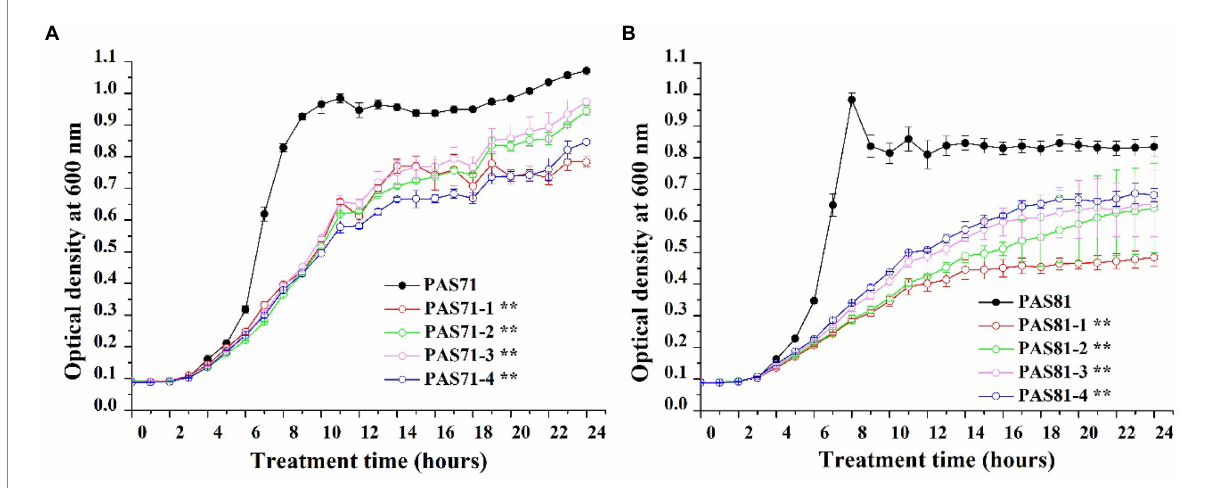
FIGURE 2 Growth curves of Pseudomonas aeruginosa PAS71 and PAS81 parental strains and their four heteroresistant subpopulation isolates. (A) The P. aeruginosa PAS71 parental strain and its four heteroresistant subpopulation isolates. (B) The P. aeruginosa PAS81 parental strain and its four heteroresistant subpopulation isolates. k value denotes slope of growth curve cultured for 6 to 10 h; ** indicates an extremely significant difference in k value with p < 0.05 compared with the parental train based on the independent Student’s t -test.